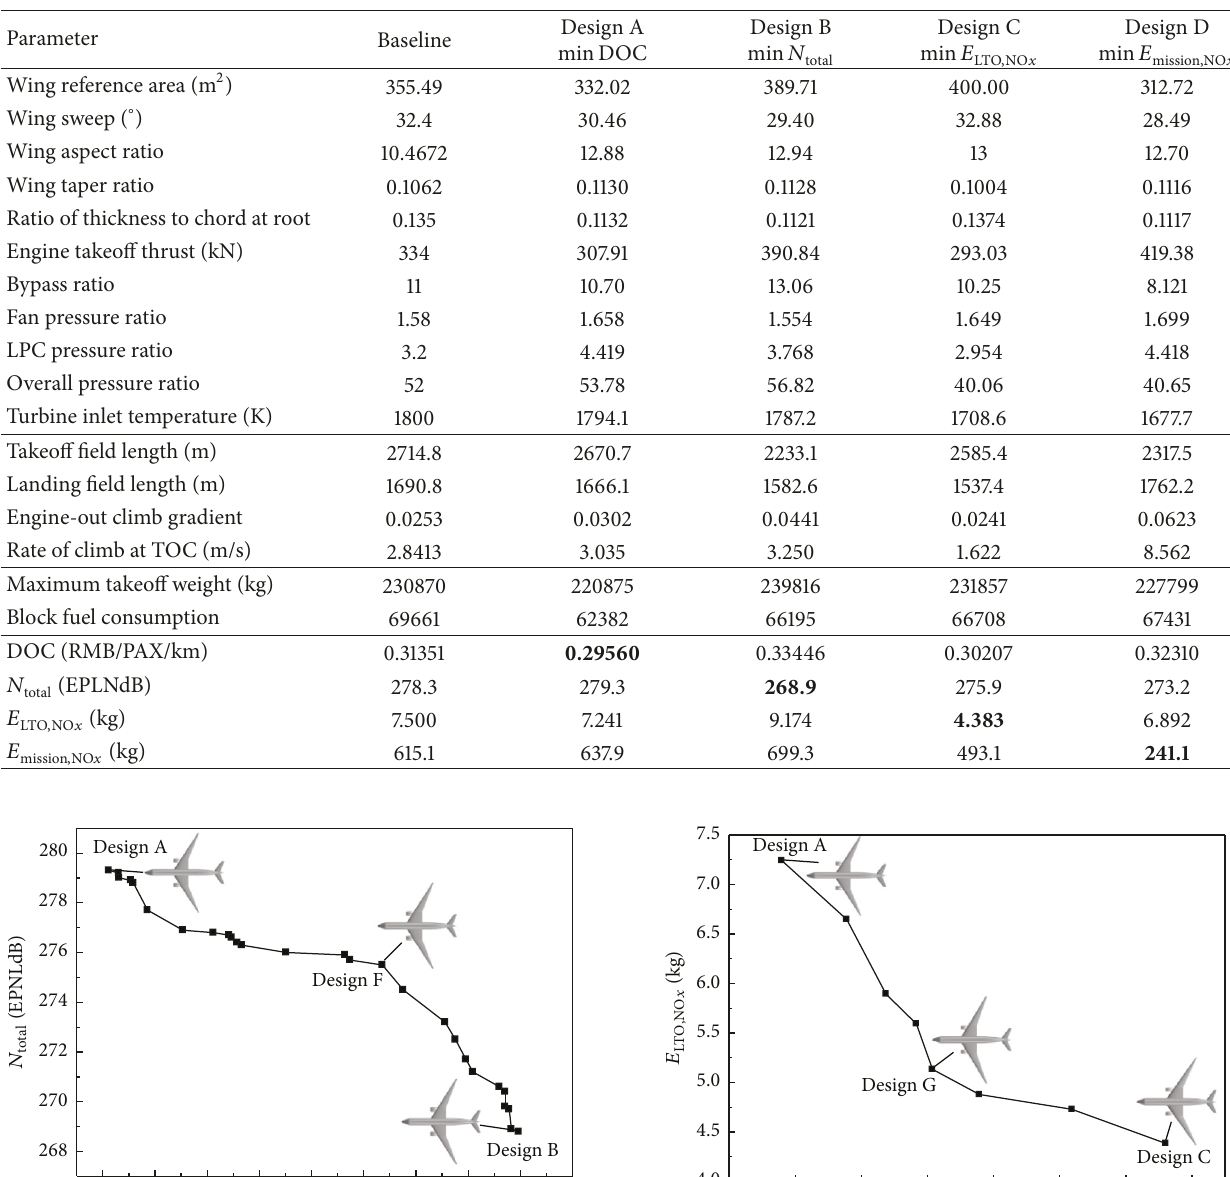
Table 5: Results of single objective optimization cases.